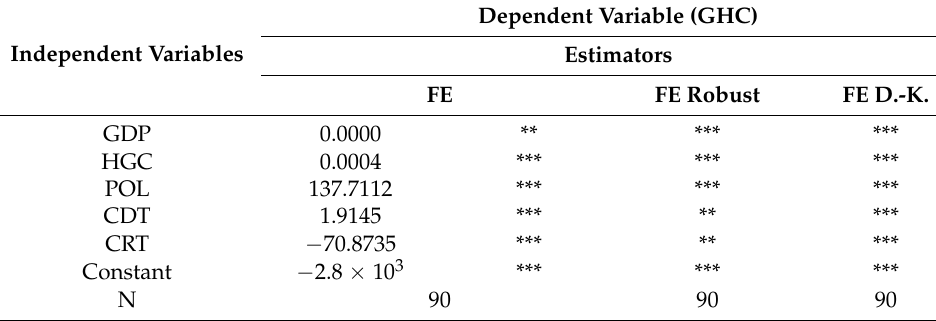
Table 9. Results from OLS with fixed effect